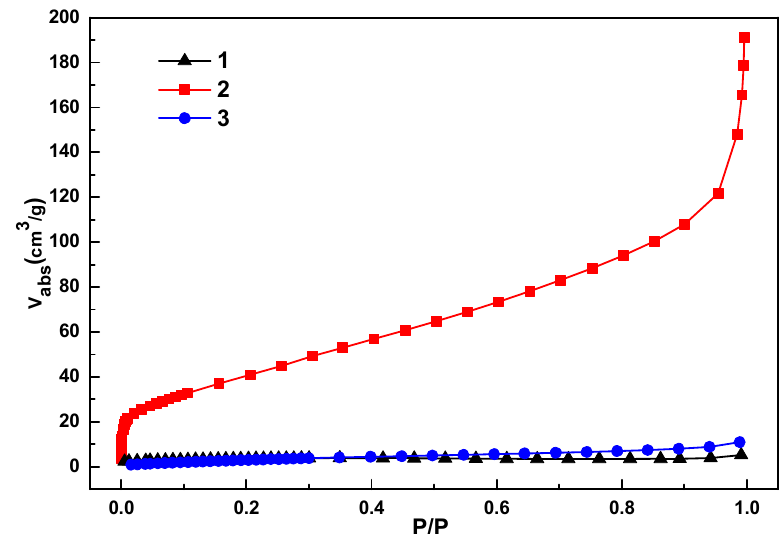
Figure 4. The N gas adsorption isotherms for 1 – 3 at 77 K. Figure 4. The N 2 gas adsorption isotherms for 1 – 3 at 77 K. 2 Figure 4. The N 2 gas adsorption isotherms for 1 – 3 at 77 K.